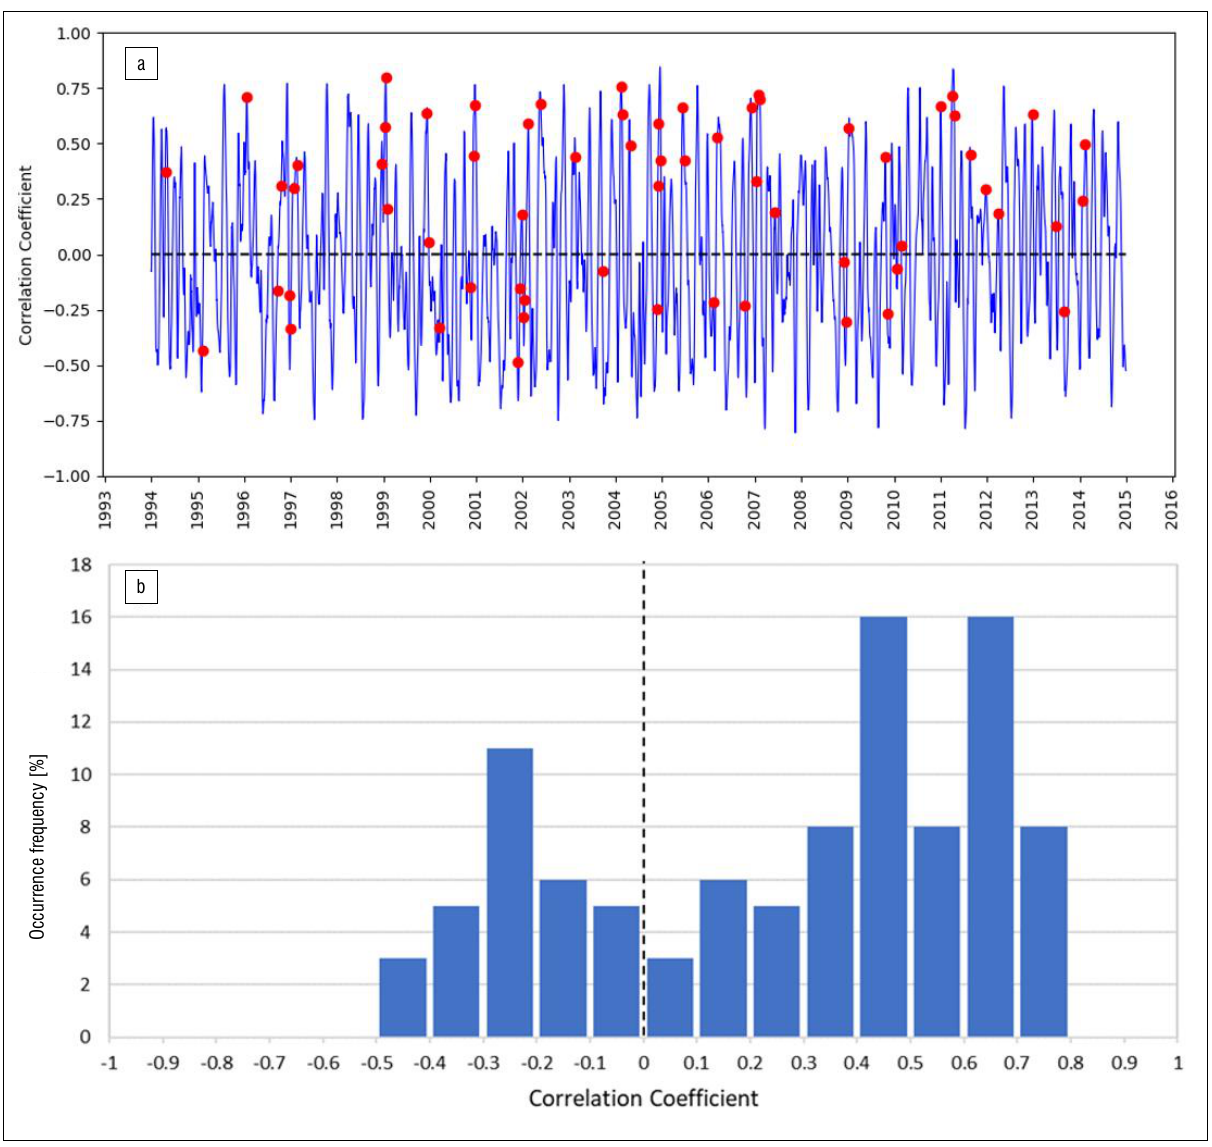
(a) Time series of cross-correlation coefficients. The temporal positions of the temperature anomalies are denoted by red dots. (b) Histogram of the cross-correlation coefficients of the sea surface height (SSH) at the peak of the individual temperature anomalies to the conditionally averaged